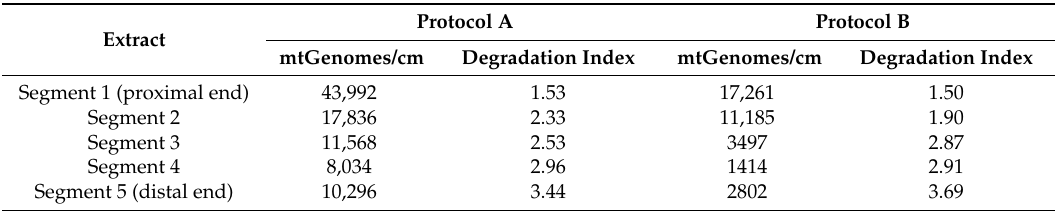
Table 3. Mitochondrial DNA (mtDNA) quantitation values and degradation index values for one recent segmented hair (R7) purified using protocols A and B. mtGenomes: mtDNA genome.